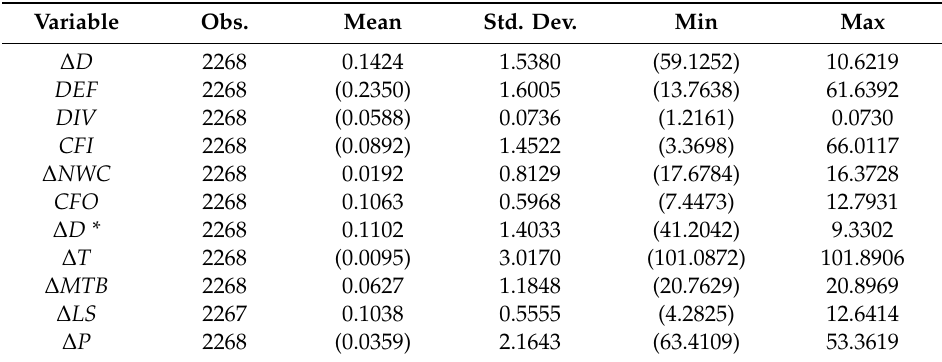
Table 1. Descriptive Statistics.